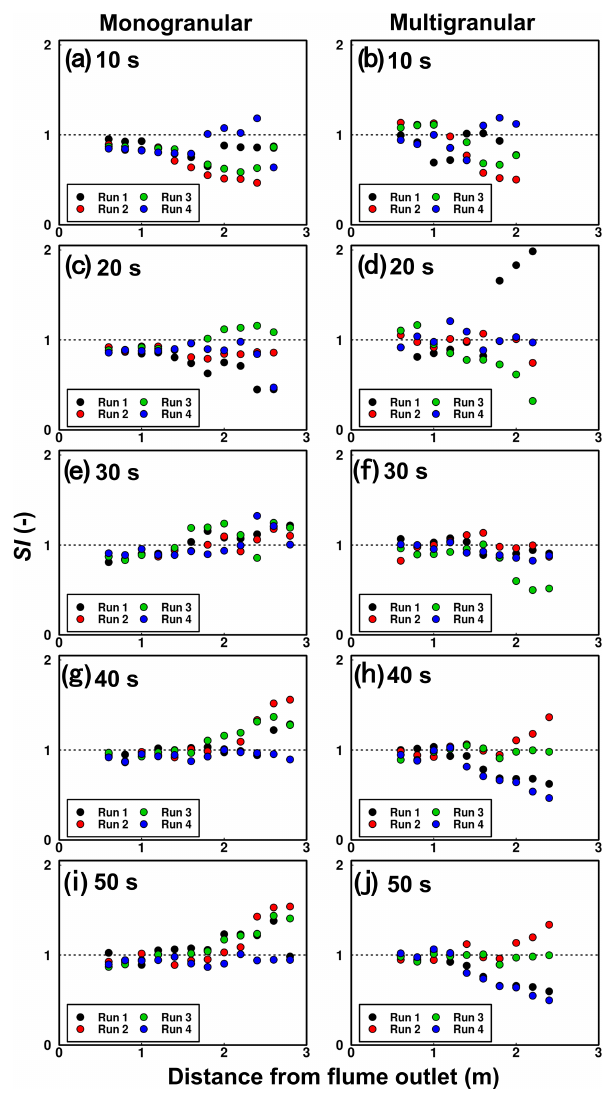
Figure 17. Changes in symmetric index (SI) values in response to fan-morphology formation. The left and right panels show re- sults for monogranular flows and multigranular flows, respectively: (a, b) after 10s from the start of flow runout, (c, d) after 20s from the start of flow runout, (e, f) after 30s from the start of flow runout, (g, h) after 40s from the start of flow runout, and (i, j) after 50s from the start of flow runout.